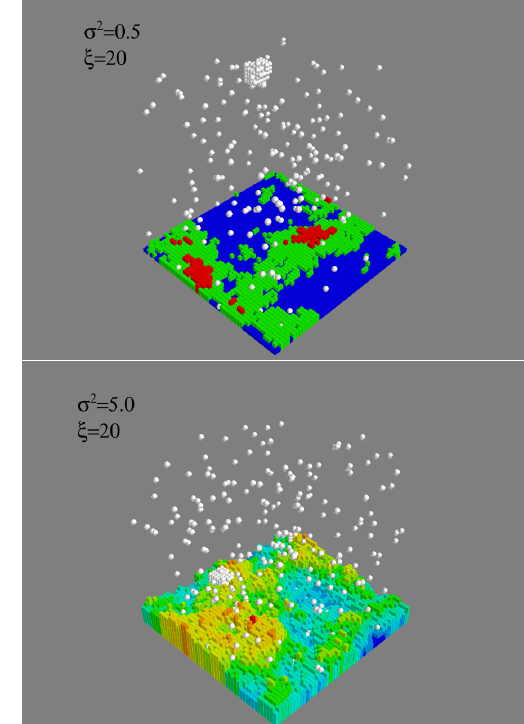
Figure 7. Configurations of the system in contact with substrates with different topographies. The largest cluster size is λ = 100. Surfaces on the left column: correlation length ξ = 5, 10,20 (from top to bottom), and variance σ 2 = 0.5. Surfaces on the right column: correlation length ξ = 20 and variance σ 2 = 0.5,2.5,5.0 (from top to